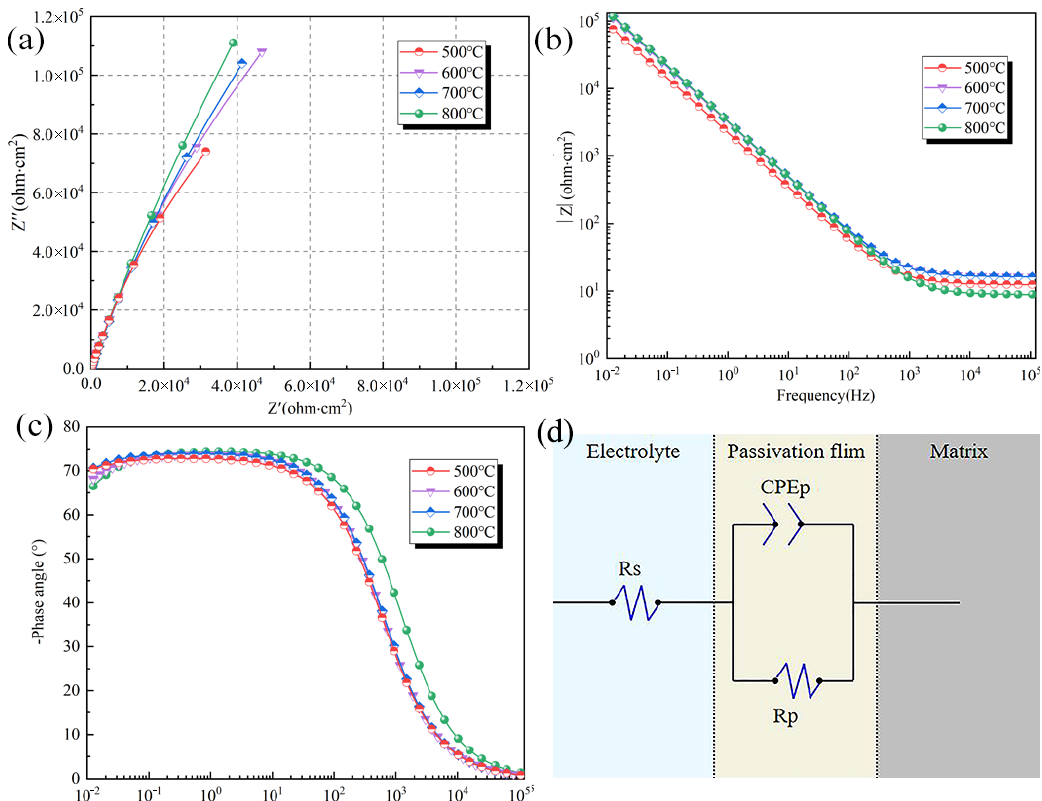
Figure 10. Electrochemical impedance spectroscopy of Ti-20Zr-15Mo alloys after annealing: ( a ) Nyquist plots; ( b ) Bode impedance plots; ( c ) Bode phase angle plots; ( d ) equivalent circuit diagram.